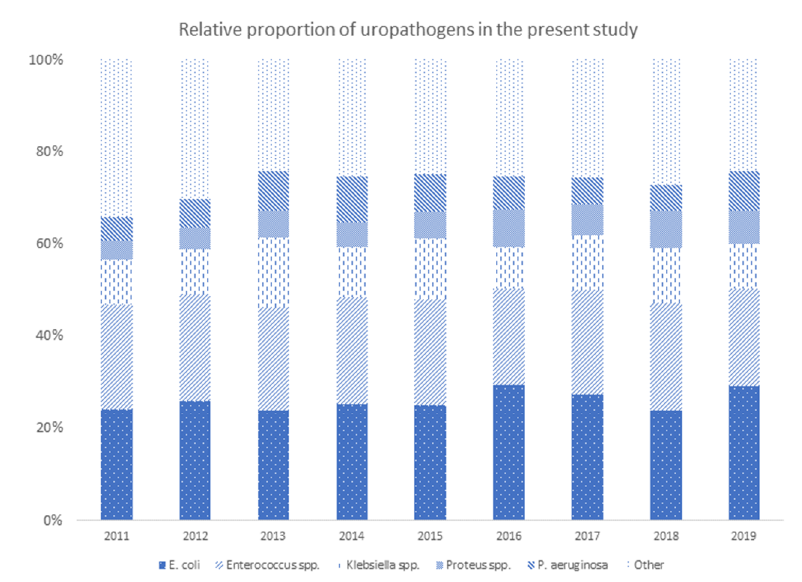
Figure 1. Spectrum of uropathogens during the study period (relative